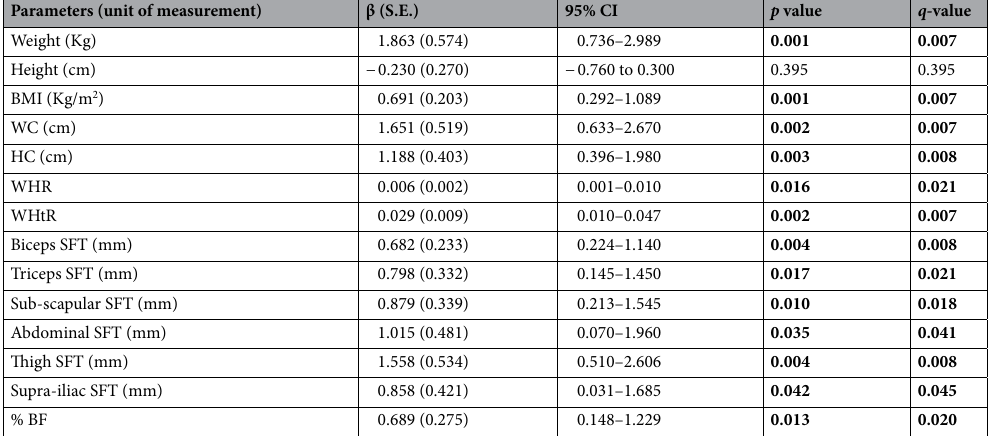
Table 4. Association of the genetic risk score with obesity-related anthropometric variables. BMI body mass index, WC waist circumference, HC hip circumference, WHR waist-to-hip ratio, WHtR waist-to-height ratio, SFT skinfold thickness, % BF body fat percentage, SE standard error, CI confidence interval, q-value corrected p value. The association of the genetic risk score with anthropometric traits was determined by linear regression. Effect size (β) and 95% confidence intervals were computed to seek rise or fall in the selected parameter per each risk allele increase. All association analyses were adjusted for age and gender and corrected for multiple comparisons via the Benjamini–Hochberg method. A p value < 0.05 was considered statistically significant. The significant p values are indicated in bold .